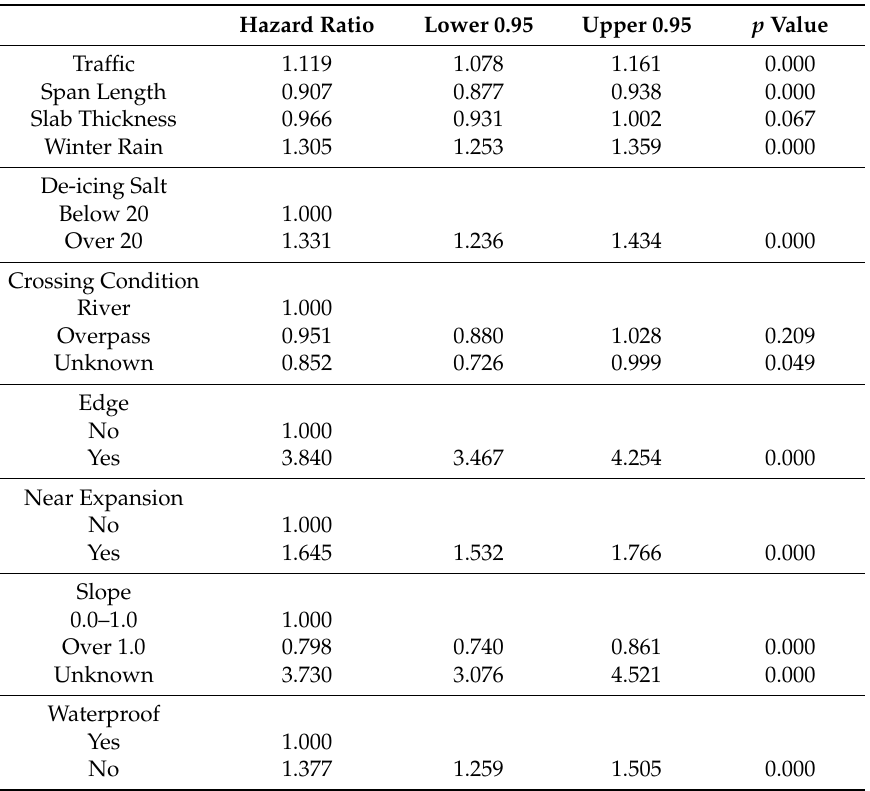
Table 3. Multivariate Cox regression analysis result for East